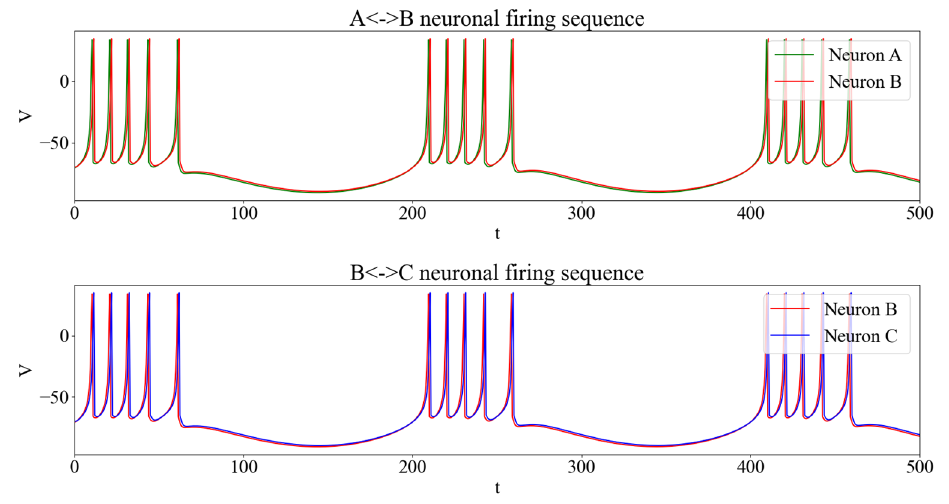
Figure 8. The discharge sequence of three neurons connecting model 1(b-3).